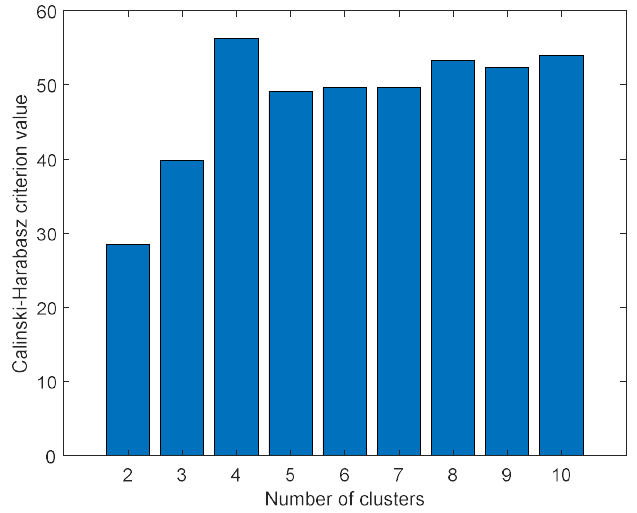
Figure 16. Calinski–Harabasz criterion values at different number of clusters (K).